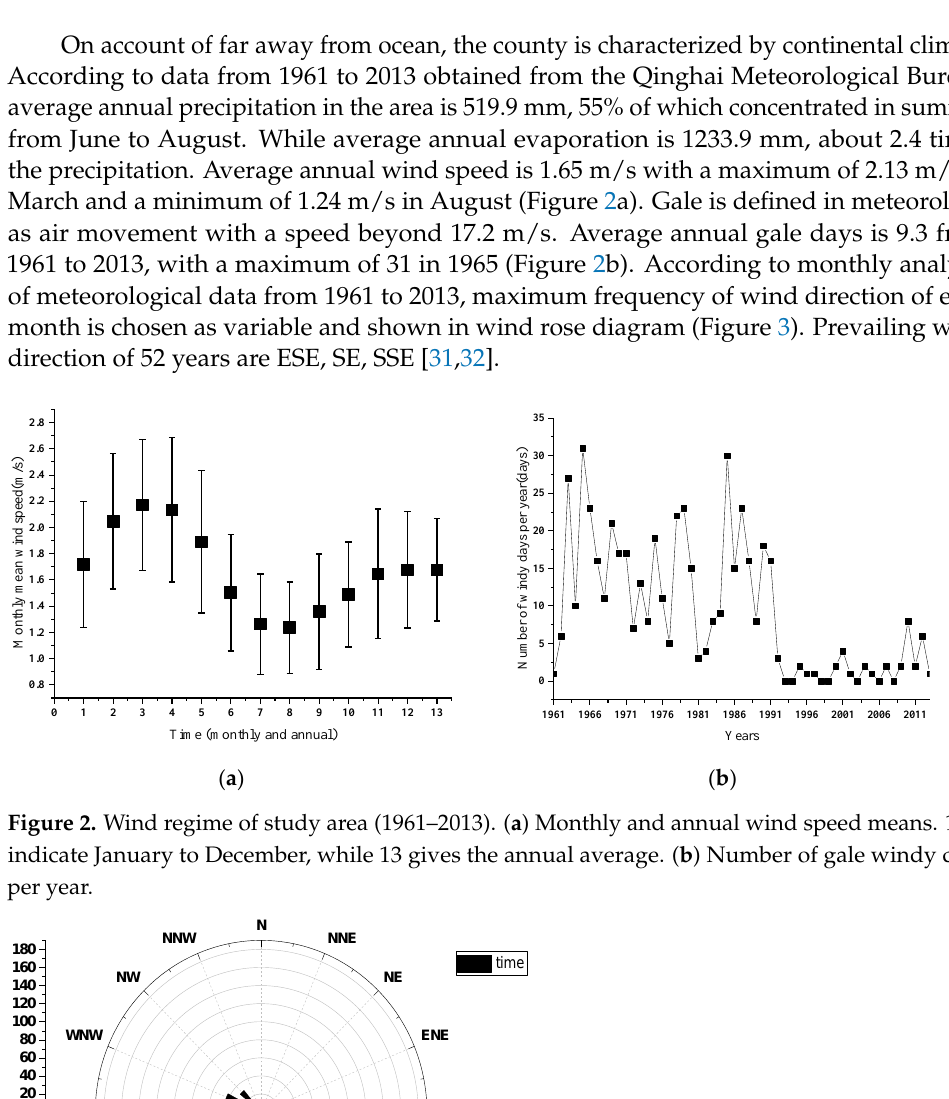
Figure 1. Location of the Great Wall of the Ming Dynasty in Datong County of Qinghai Province, China.